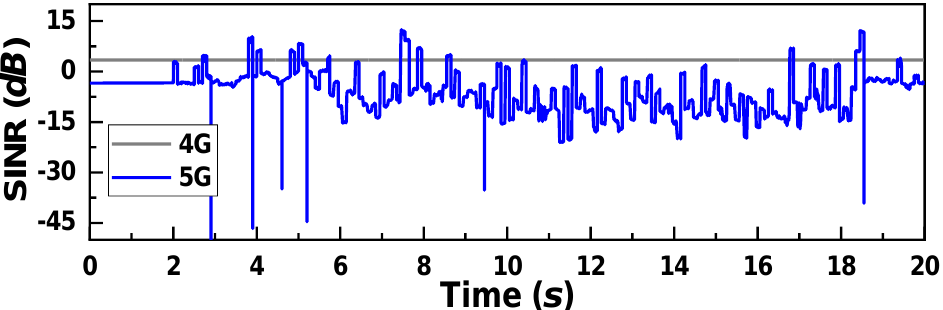
Figure 3. Measured SINR for a test simulation experiment.